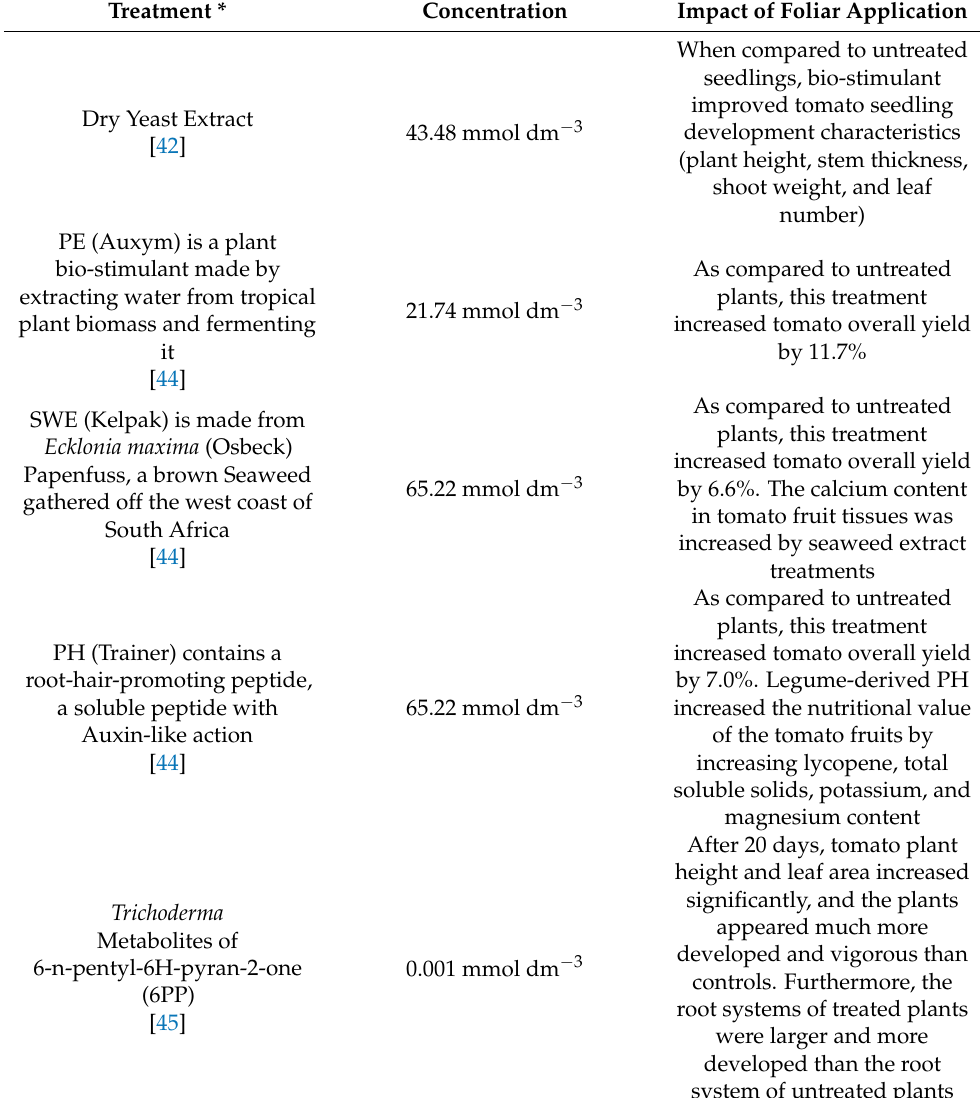
Table 6. Cont. Treatment